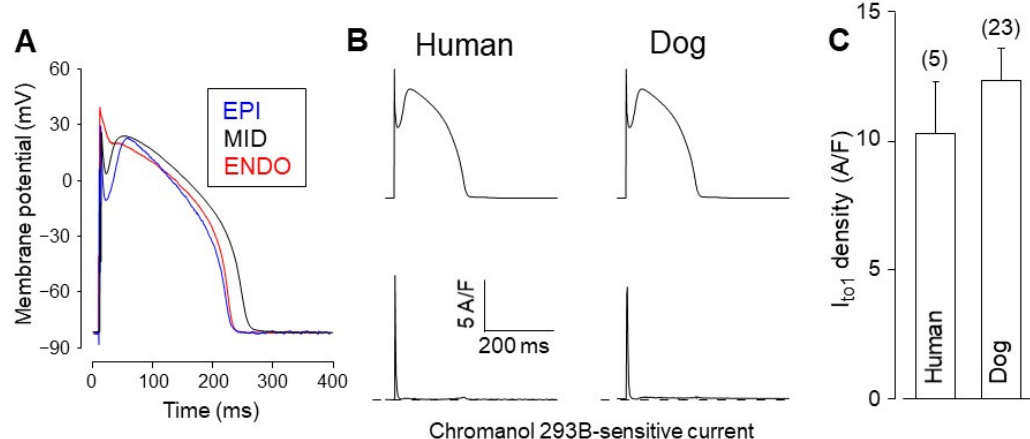
Figure 3. Transient outward K + currents in human and canine left ventricular myocytes. ( A ) Differences in action potential morphology in canine ventricular cells derived from the subepicardial (EPI), midmyocardial (MID), and subendocardial (ENDO) layers. ( B ) Command action potentials (top) and transient outward K + current (I to1 ) records (bottom) taken from midmyocardial human and canine myocytes under action potential voltage clamp conditions. The cycle length of stimulation was 700 ms in the canine and 1000 ms in the human cells. ( C ) Average I to1 densities. I to1 was defined as a 100 µ M chromanol 293B-sensitive current. Columns and bars are mean ± SEM values, ( n ) denotes the number of myocytes studied. Unpublished data from Varr ó et